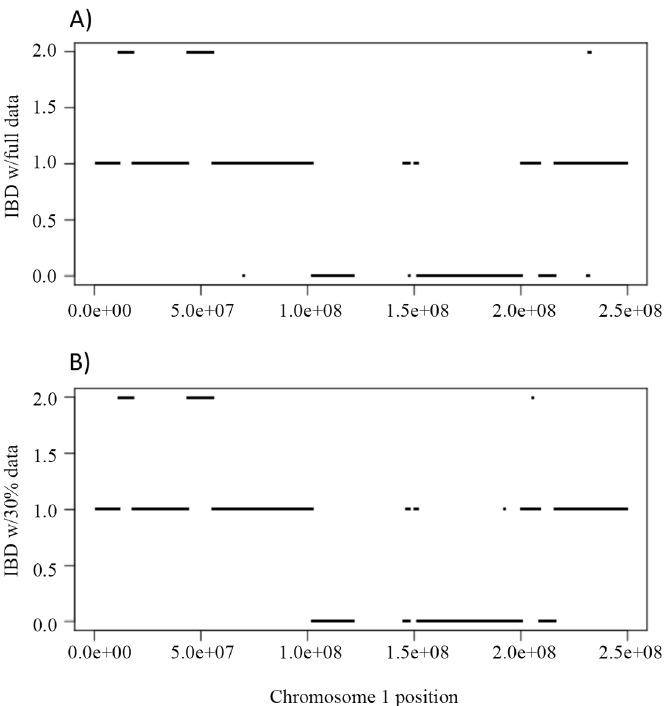
Fig 6. The IBD sharing and genotype accuracy of Illumina HiSeq sequencing data on chromosome 1 in a Nuc6 subpedigree from the CEPH 1463. A) shows the IBD of the siblings NA12879, NA12880 when the full data (~50X) were used to infer the inheritance vectors. B) shows the corresponding IBD when 30% (~15X) data were